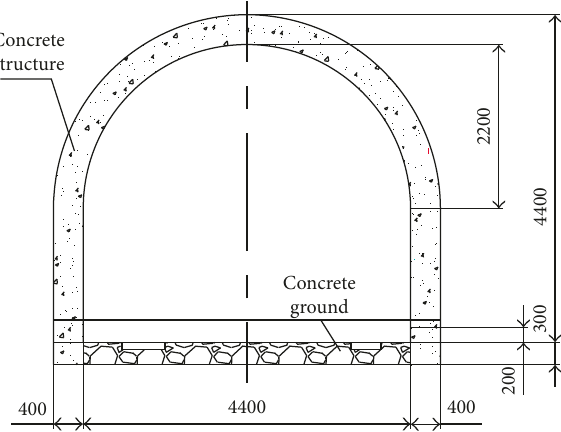
Figure 2: Preliminary supporting section.